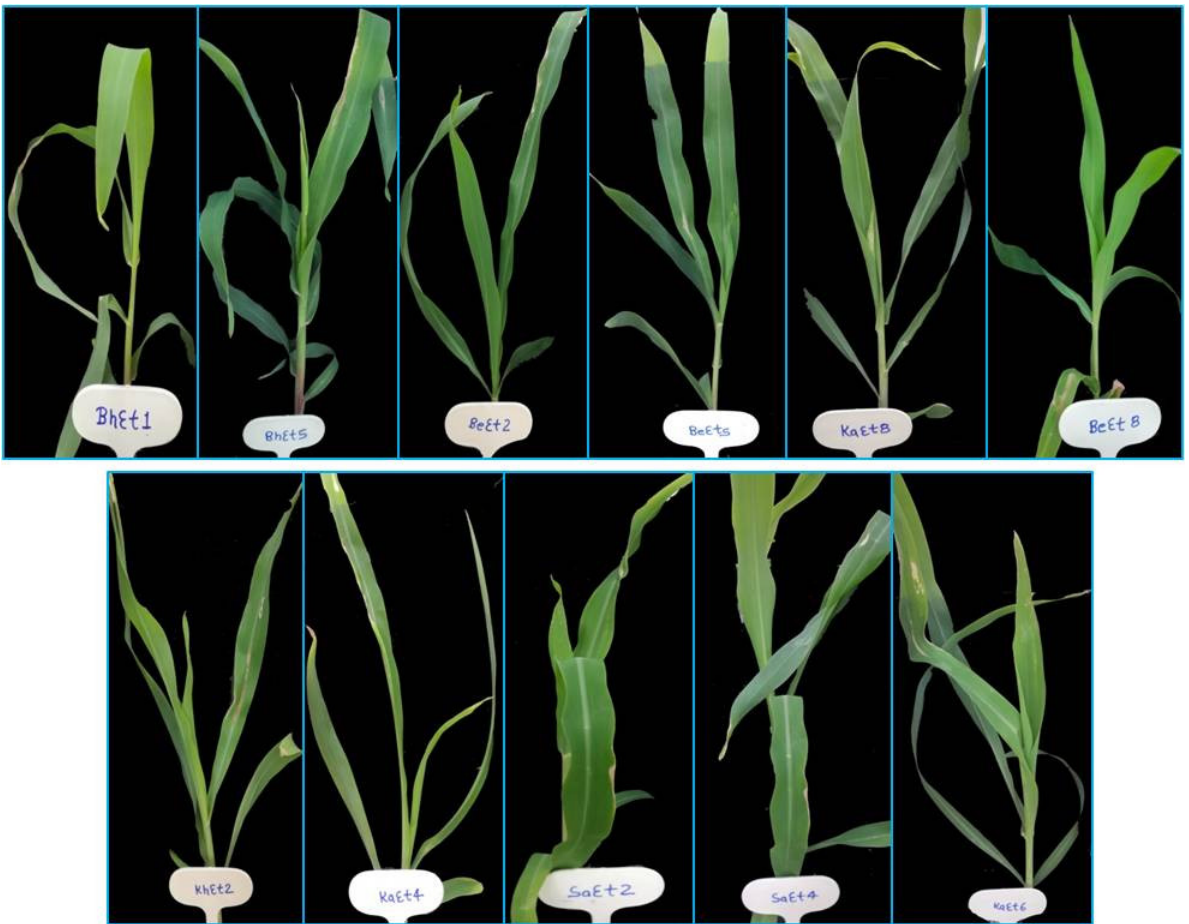
Figure 4. Disease reaction of E. turcicum race 123N on differential line ‘2′ after 14th days of inocu- lation.